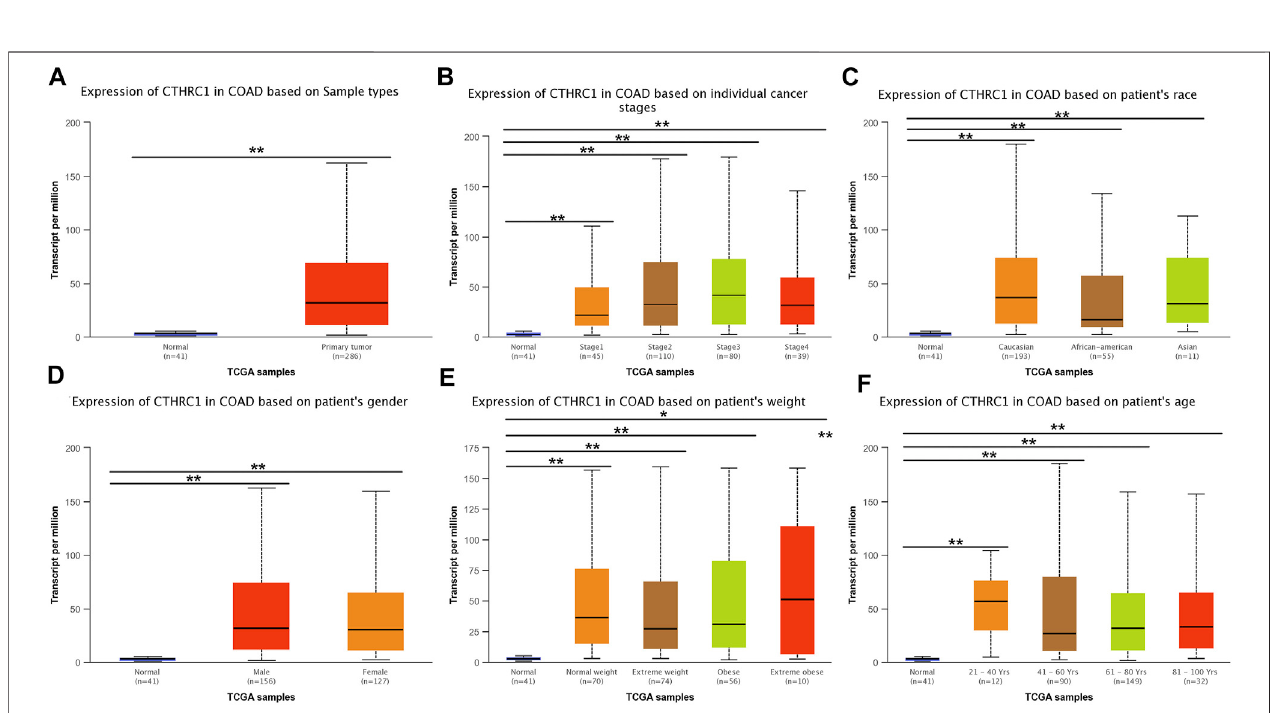
Frontiers in Molecular Biosciences |